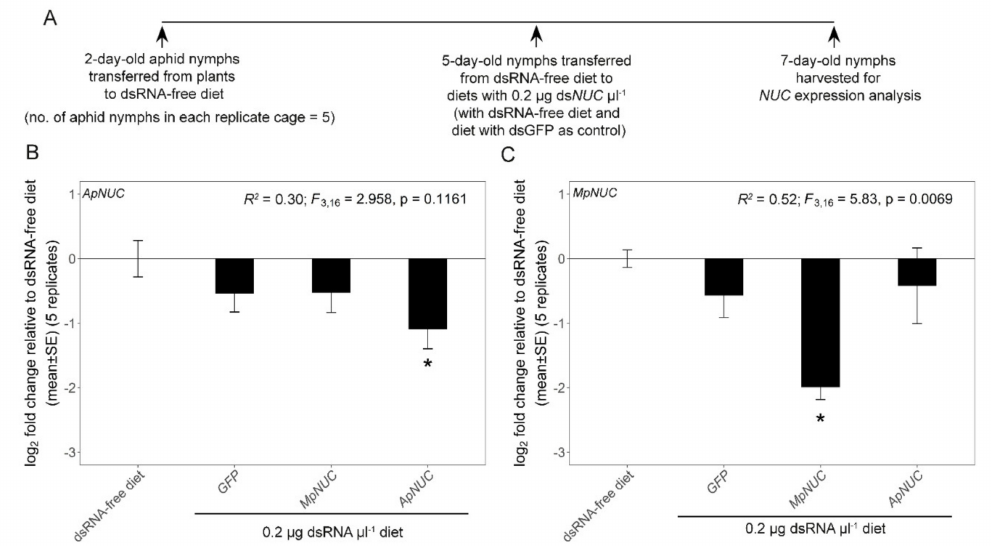
Figure 3. Cross-reactivity of ds NUC between aphid species. Fold-difference in NUC expression of aphids administered dsRNA at 0.2 µ g µ L − 1 in the diet for two days. ( A ) Experimental design. ( B ) A . pisum NUC gene expression. ( C ) M . persicae NUC gene expression. The experiment comprised five replicate cages for each treatment. Linear model statistics were employed using dsRNA-free diet as the intercept to identify significant effect of dietary dsRNAs on NUC expression. Asterisks identify treatments that were significantly different from the ds GFP -free diet at α = 0.05. ApNUC , A. pisum NUC ; MpNUC , M. persicae NUC .